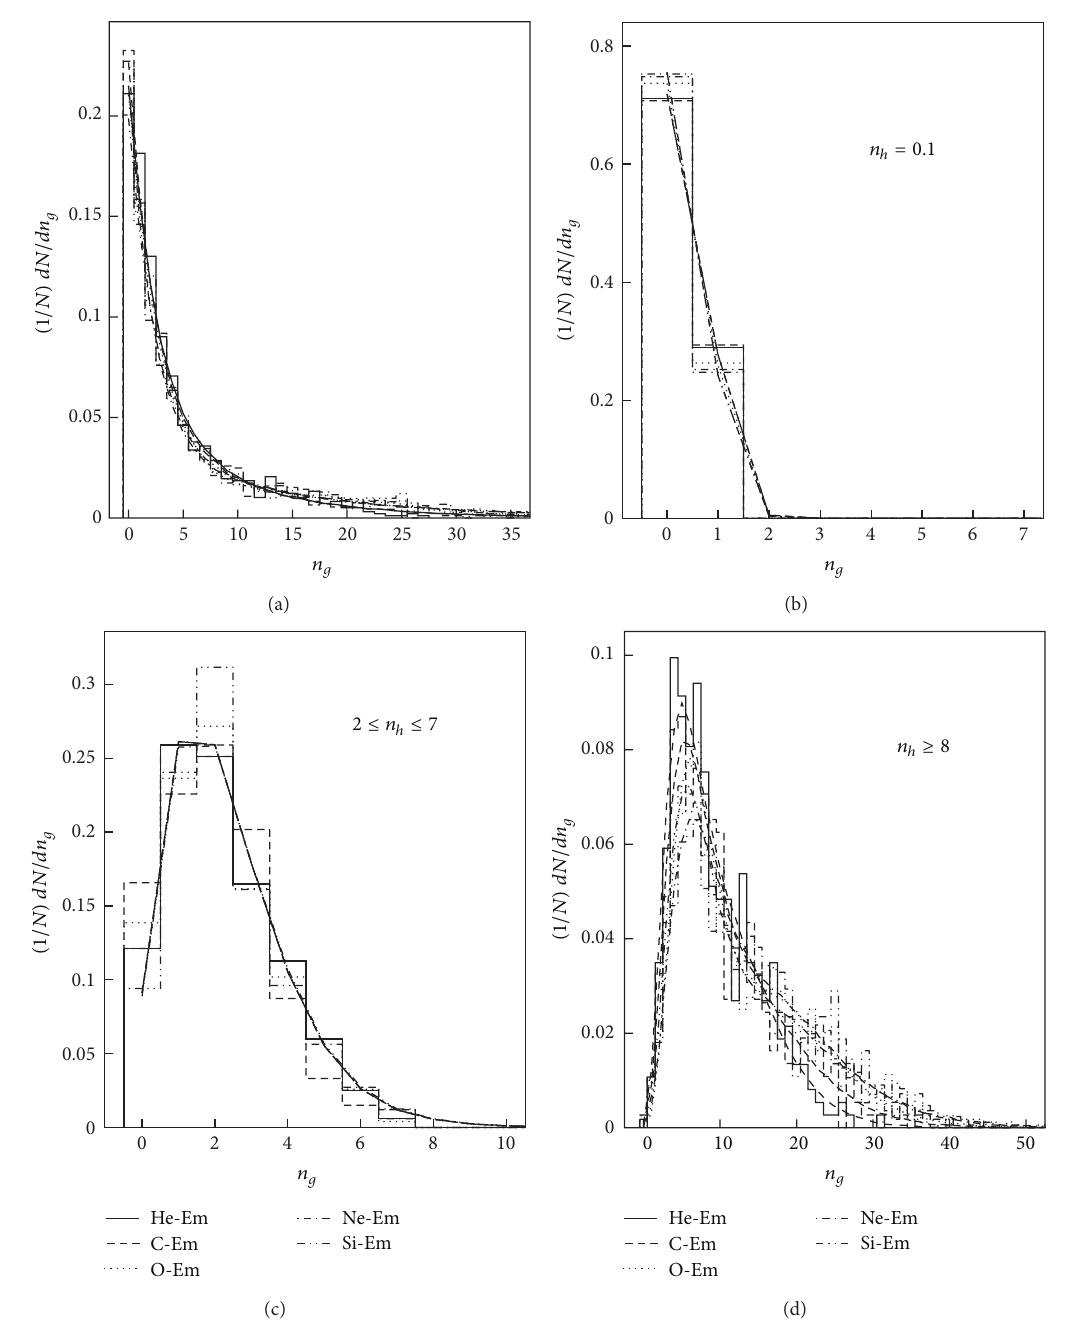
Figure 2: The normalized multiplicity distributions for the grey particles produced in the interactions of projectiles with (a) Em, (b) H, (c) CNO, and (d) AgBr, respectively. The histograms represent the experimental data, while the curves are the corresponding ones calculated according to the multisource thermal